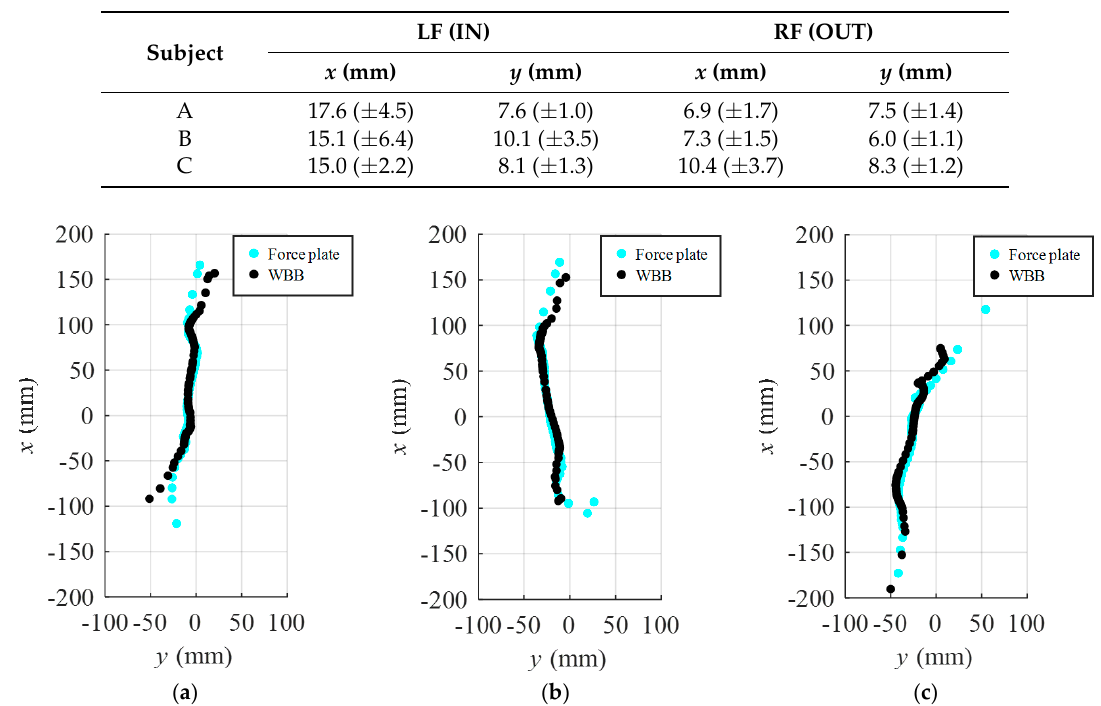
Figure 5. Center of pressure (COP) measured from the Nintendo Wii Balance Board (WBB) and the force plate in a stance while ( a ) walking straight (right foot—RF), ( b ) walking along a curved path in clockwise (CW) direction (RF (IN—inside foot turning)), and ( c ) walking along a curved path in counterclockwise (CCW) direction (RF (OUT—outside foot turning)). Table 4. Root-mean-square error (RMSE) of center of pressure (COP) comparing measurements from the Nintendo Wii Balance Board (WBB) with those from the force plate while walking straight.